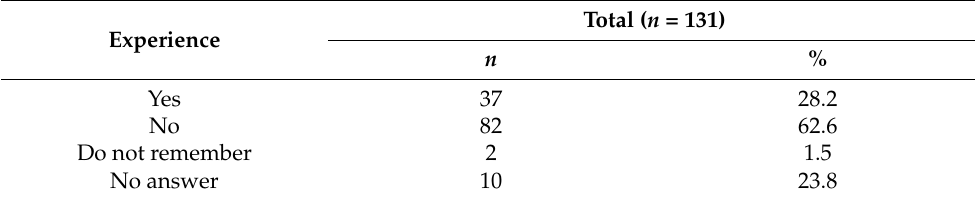
5 of 11 Figure 1. Average self-medication over 1 year. N/A = no answer. The use of analgesics is shown in